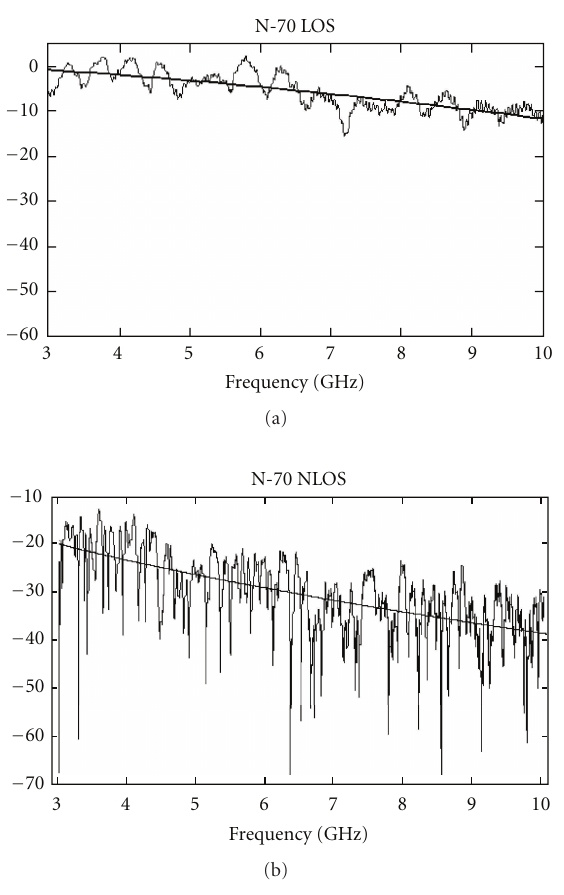
Figure 11: Frequency decaying factor at level 70 in LOS and